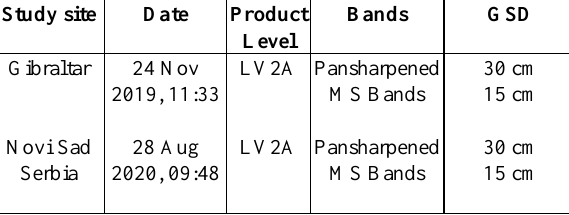
Table 1. MAXAR datasets used in LULC map production.